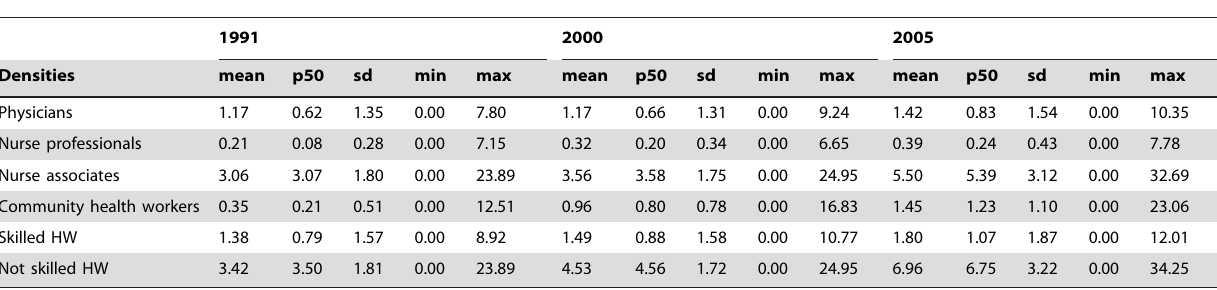
Table 1. Descriptive statistics.